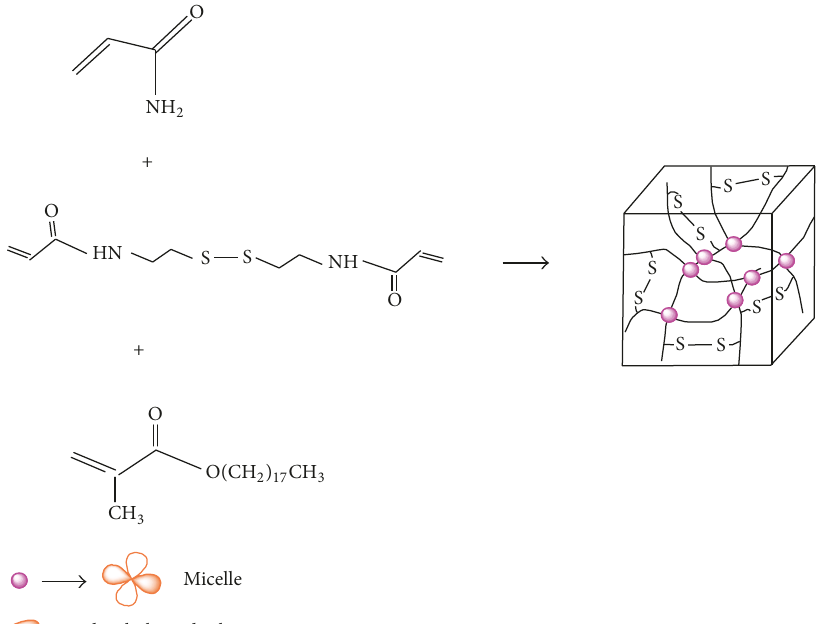
Figure 1: The equation of octadecyl methacrylate-acrylamide-N,N 󸀠 -bis(acryloyl)-cystamine